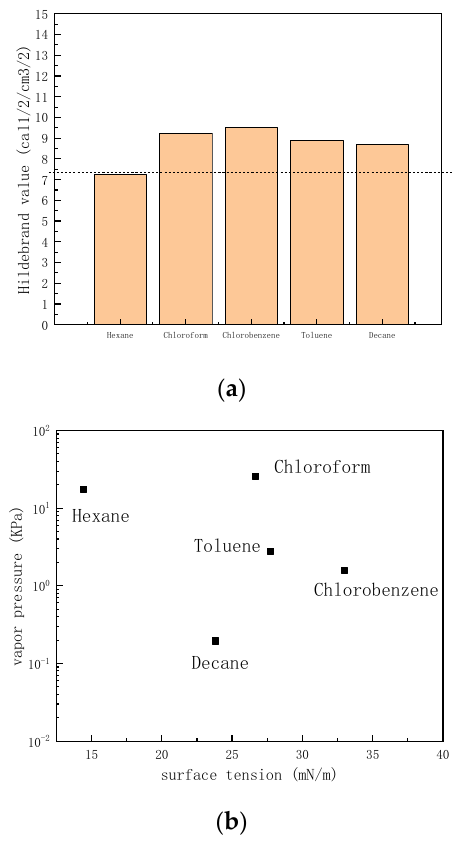
Figure 1. ( a ) Swelling relationship between PDMS and several solvents (The dashed line is the Hildebrand value of PDMS, δ = 7.3 cal 1/2 /cm 3/2 ), ( b ) Surface tension ( γ ) vs. vapor pressure ( P v ) of selected solvent at room temperature.